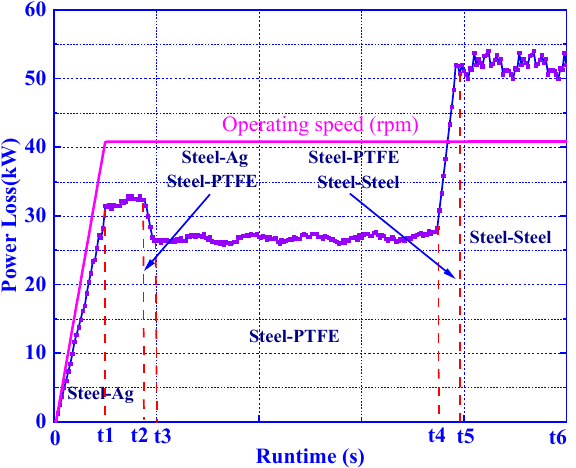
Figure 11. Power loss of ball bearing during the operation. When the ball bearing is working at different speeds, the components of power loss in the three stages are shown in Figure 12.